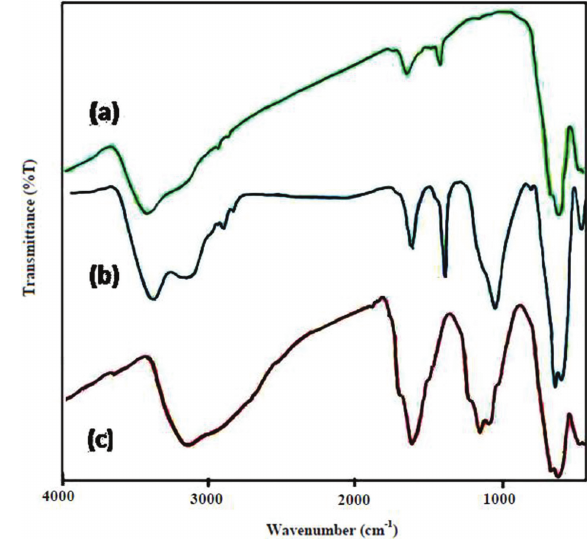
Figure 3: FT-IR spectra of (a) Fe SiO -L-proline nanoparticles. 2